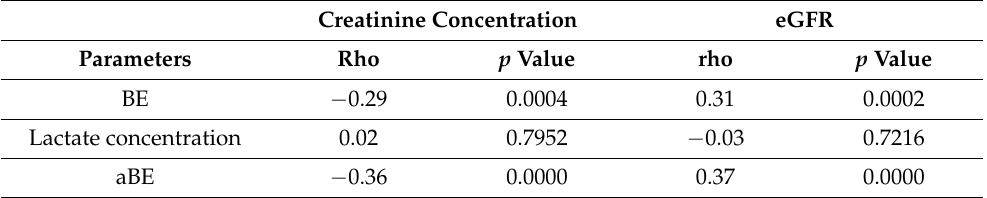
Table 4. Spearman correlation between renal function indices and BE, aBE, and lactate